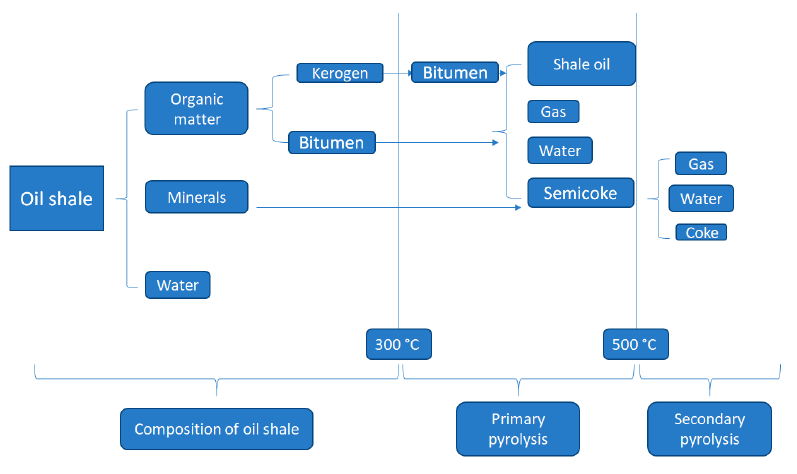
Fig. 3. Pyrolysis of oil shale